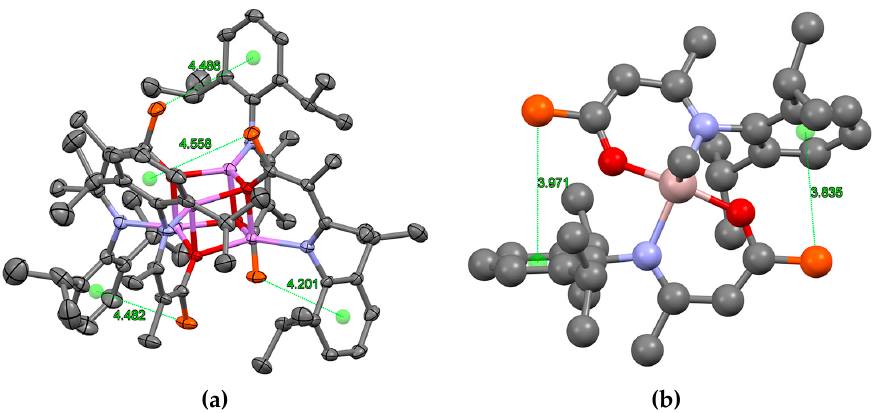
Figure A3. Orientation and distance of ketoiminate methyl carbon atoms (coloured orange) to aryl ring centroids (light green) of the adjacent ligands. Contrast the longer distances and poorer orientation in ( a ) 3b with the more favourable situation in ( b ) the structure with the refcode BAMFAX (see [7]).